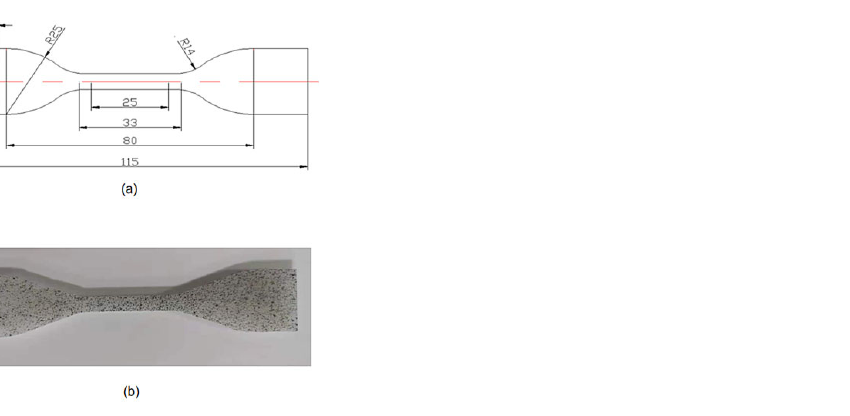
Figure 1. ( a ) Schematic diagram of the size of the specimen for uniaxial tensile experiment. ( b ) Physical image of specimen with speckle.